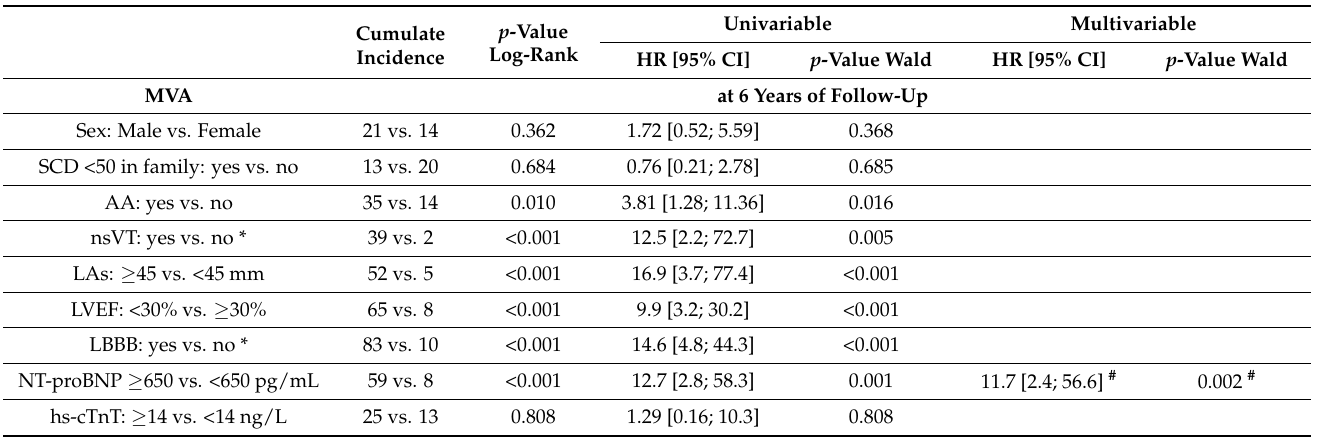
Table 4. Potential risk factors affecting occurrence of malignant ventricular arrhythmia in cardi- otitinopathy.